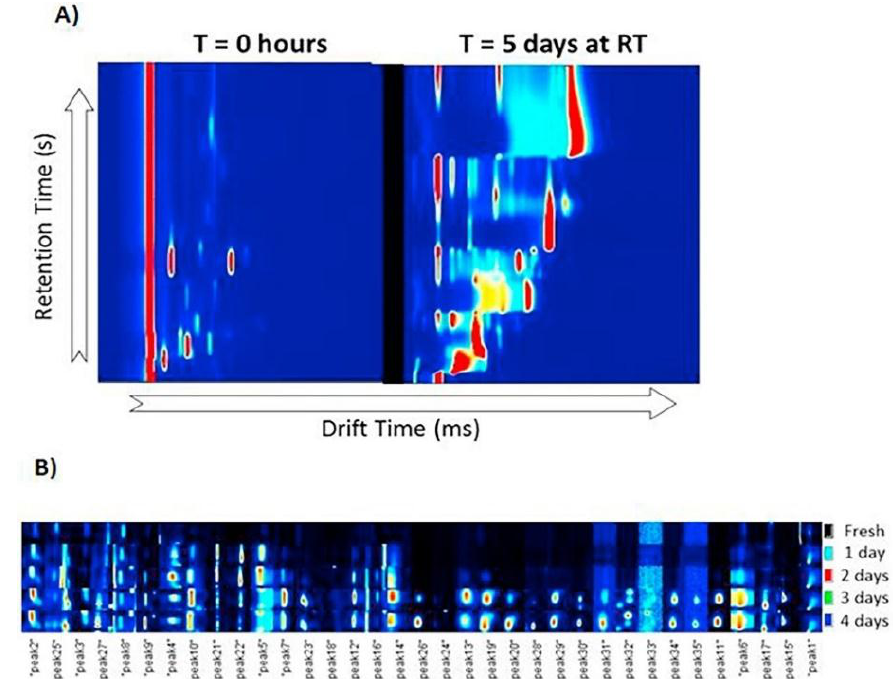
Figure 4. ( A ) Ion mobility spectrum of an egg product at T = 0 h ( left ) and after 5 days at room temperature ( right ). The red line identifies the reaction ion peak (RIP) position. ( B ) Global overview of the spots or ‘features’ identified in one egg product at different time points (from 0 to 4 days). Figure reprinted with permission from [72]. Copyright (2019) Elsevier.